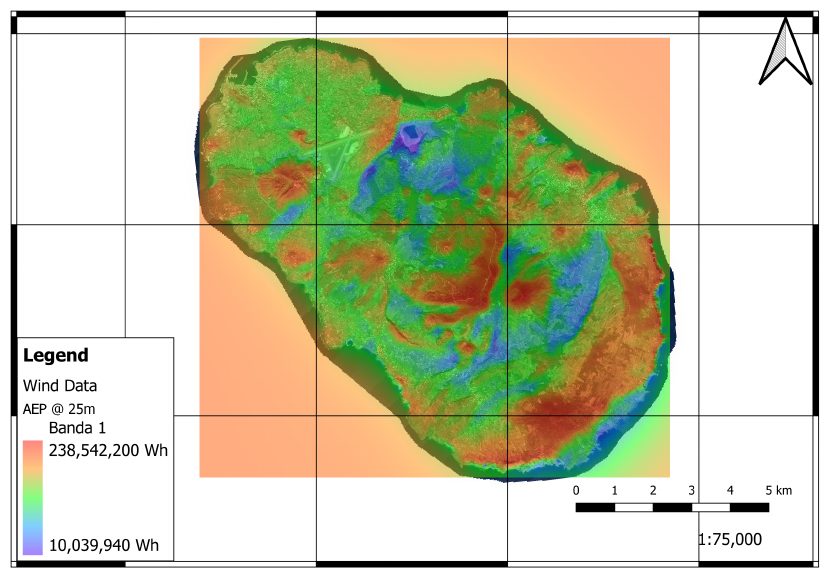
Figure 10. Annual energy